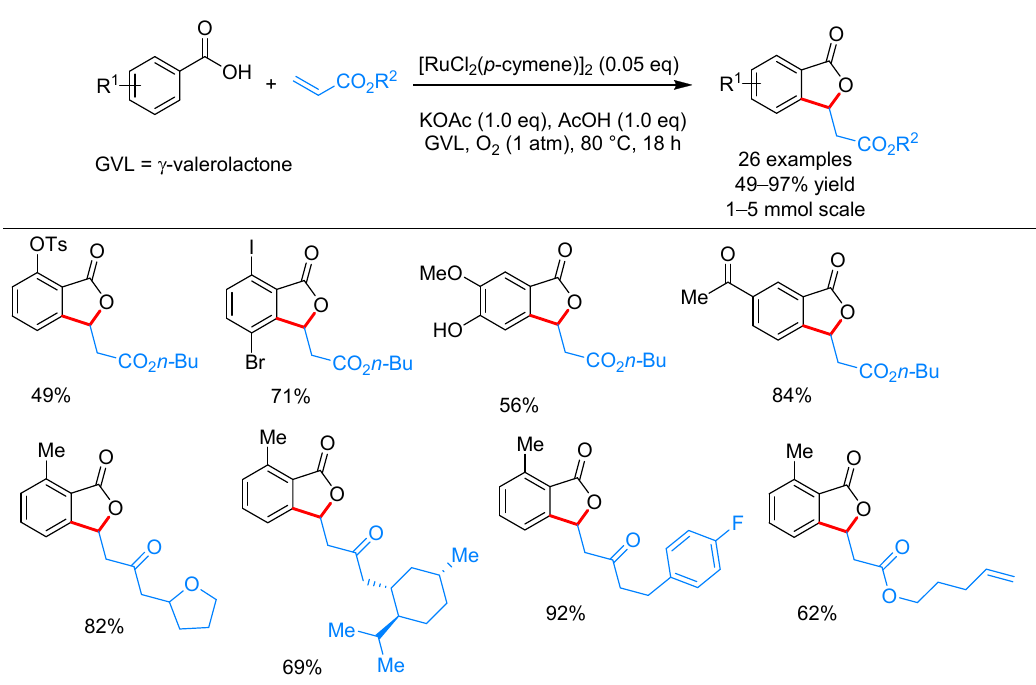
Scheme 19. Ru-catalyzed annulative coupling of benzoic acids and electrophilic alkenes for the synthesis of 3-substituted phthalides in alcohols the presence of O 2 . synthesis of 3-substituted phthalides in alcohols the presence of O 2 . synthesis of 3-substituted phthalides in alcohols the presence of O 2 .